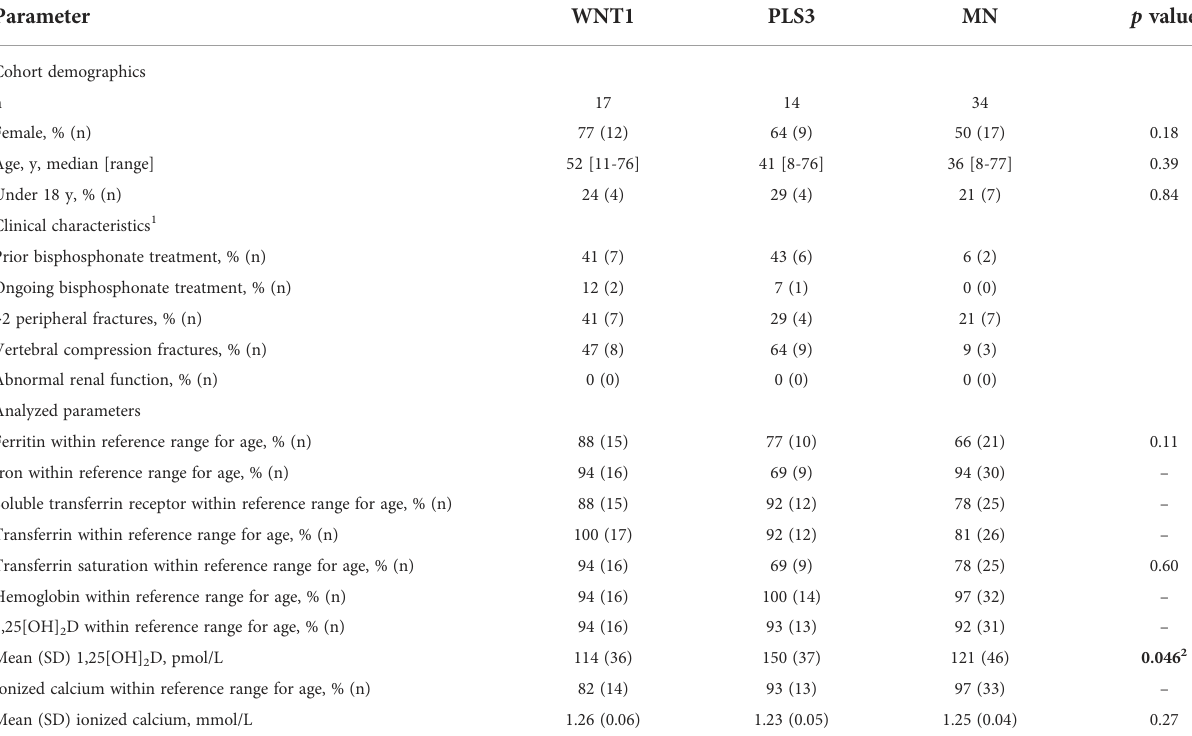
TABLE 1 Subject characteristics and prevalence of normal iron status markers in WNT1 and PLS3 mutation-positive subjects compared with mutation-negative controls (MN).